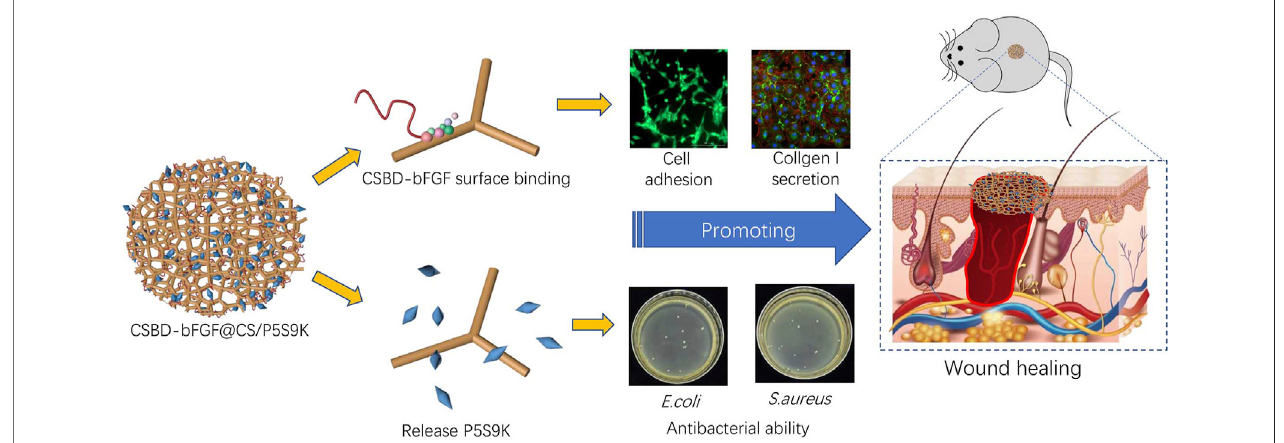
FIGURE 1 | Preparation of the CSBD-bFGF@CS/P5S9K membrane and its effect on skin wound